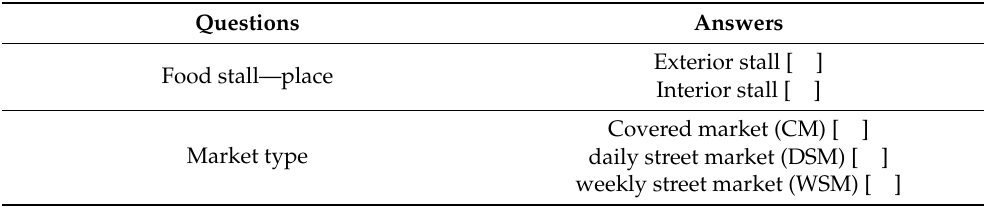
Table A3. Questions posed to vendors. Source: The